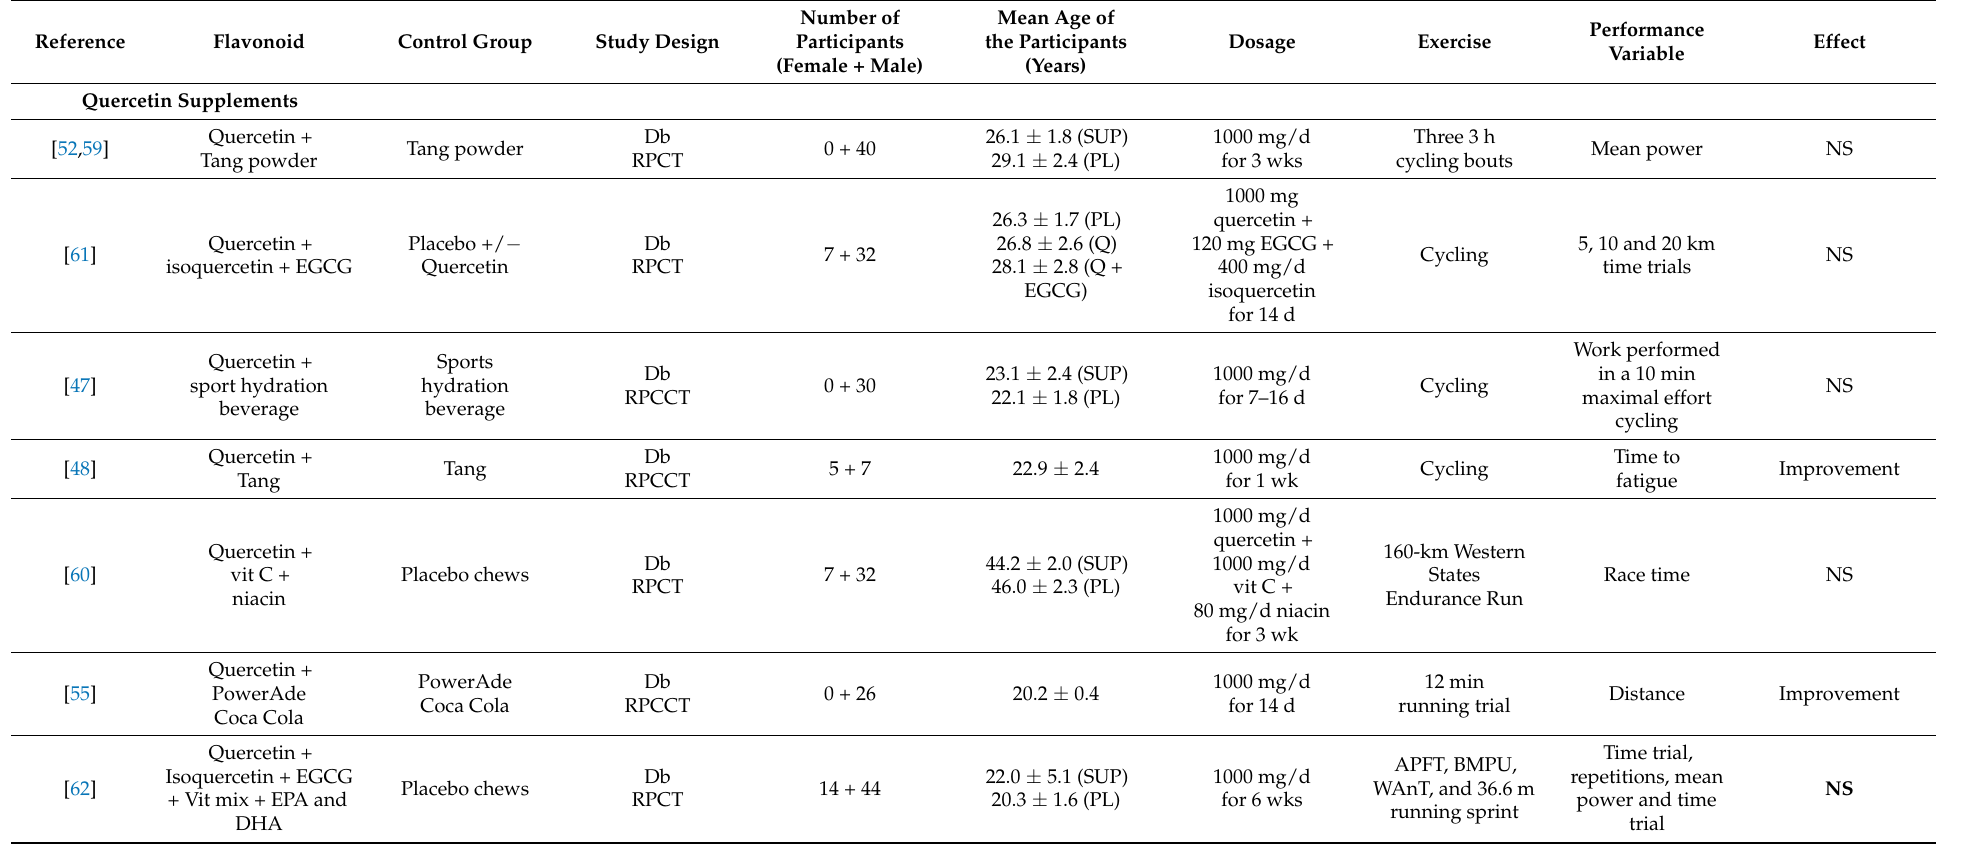
Table 1. Summary of the included studies assessing the effects of a single flavonoid intervention on exercise